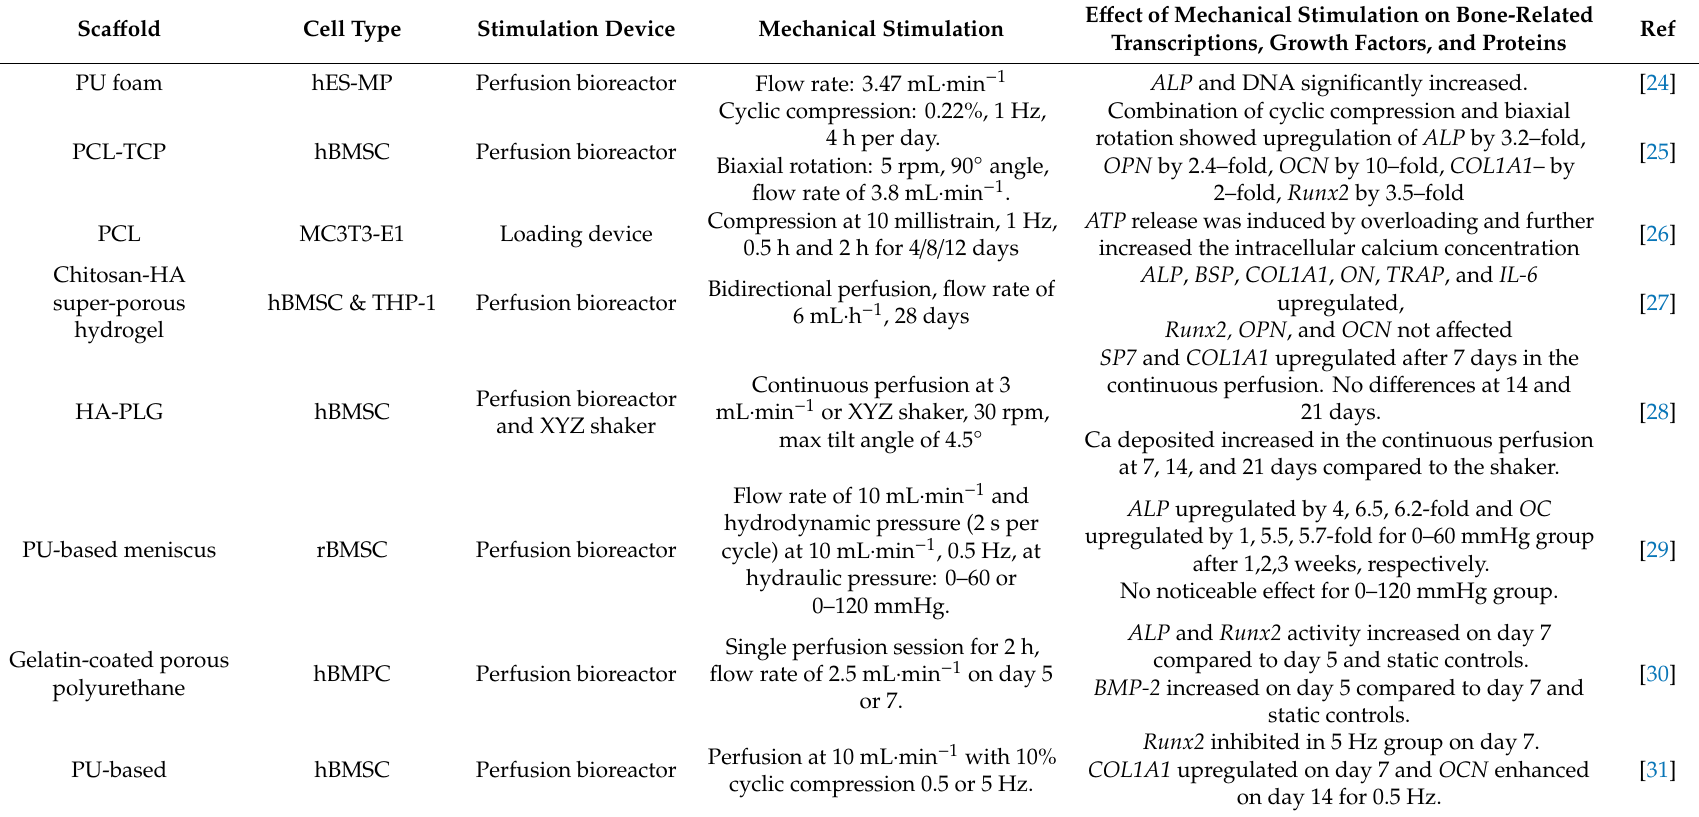
Table 1. In vitro cell mechanotransduction studies carried out during the past five years (2019–2014). Bone marrow mesenchymal stem cells, BMSCs; bone marrow-derived mesenchymal progenitor cells, BMPCs; h, human; r, rat; mouse, m; murine embryonic stem cells, mESC; human acute monocytic leukemia cell line, THP-1; human embryonic stem cell-derived mesenchymal progenitors,